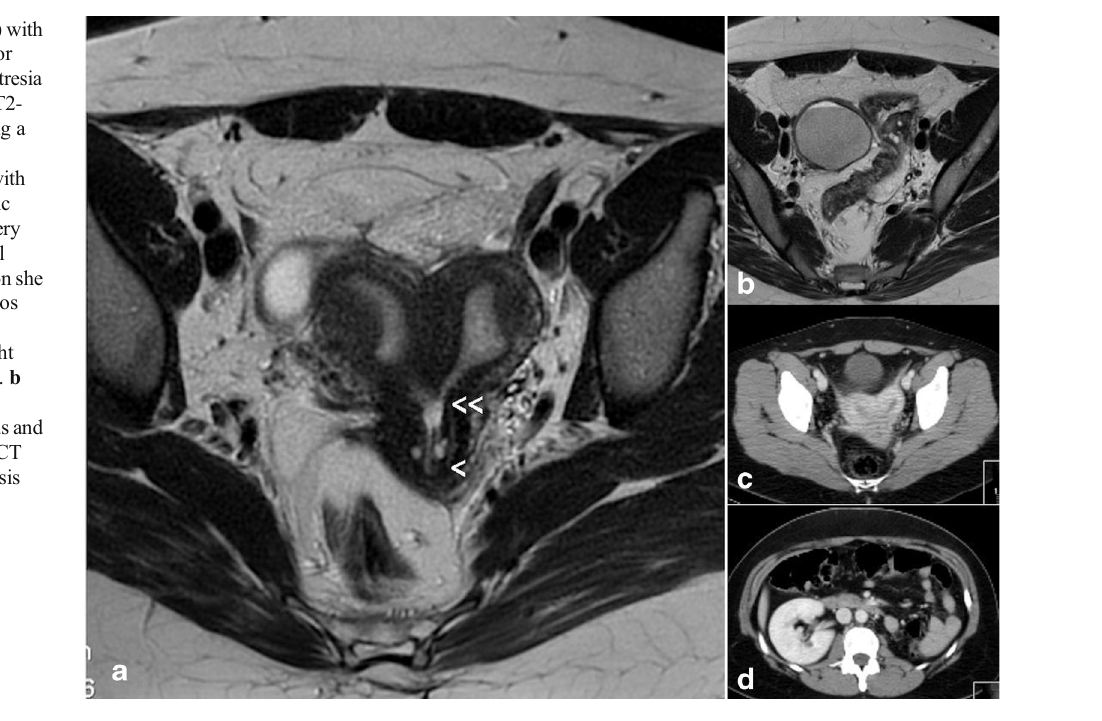
Fig. 5 Rokitansky syndrome and unicornuate uterus. a (1) CT in a patient with Rokitansky syndrome showing the utero- vaginal rudimentary area under the bladder (<<). (2) Showing both normal kidneys. b Patient with a unicornuate uterus and cavitated rudimentary uterine horn. (1) Axial and (2) T2- weighted MR image (coronal cut) showing the left cavitated and rudimentary uterine horn (<). *Left retrocervical subperitoneal serous cyst corresponding to a Müllerian remnant (excised during laparoscopy). (Modified from Acién and Acién,